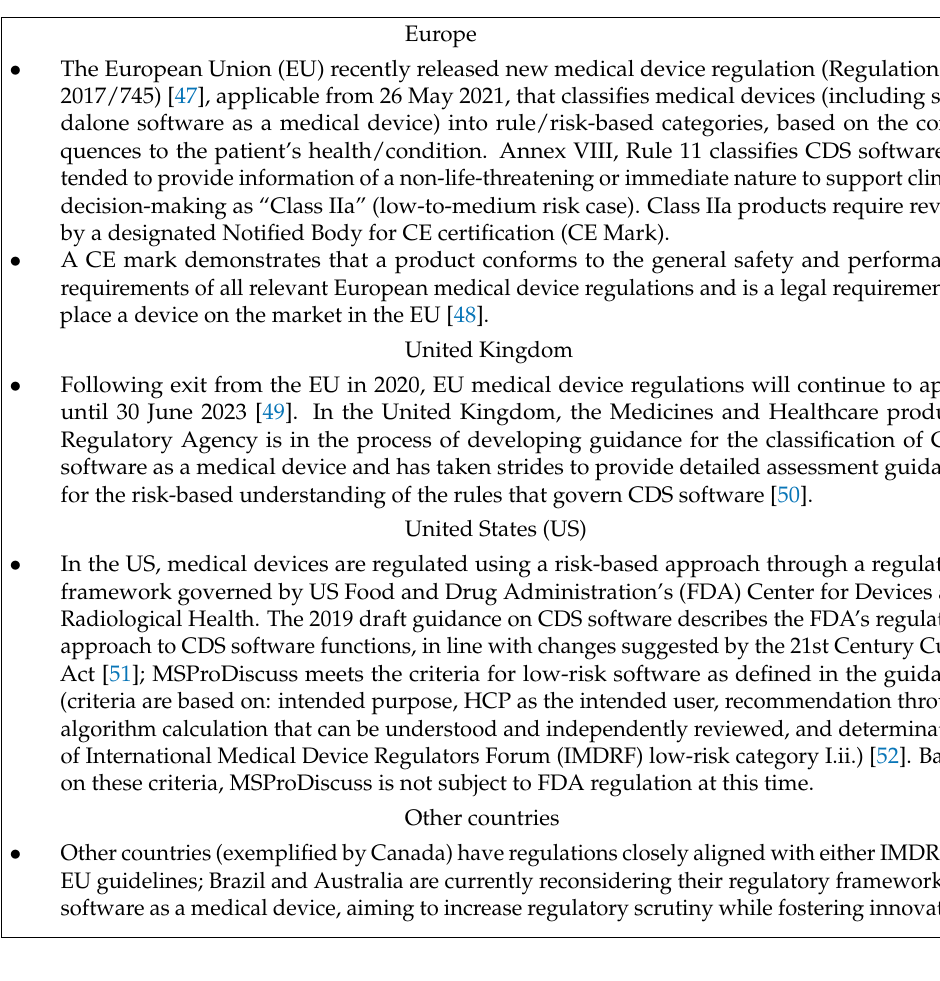
Box 1. Regulatory guidelines governing clinical decision support (CDS) software in various geo- graphical